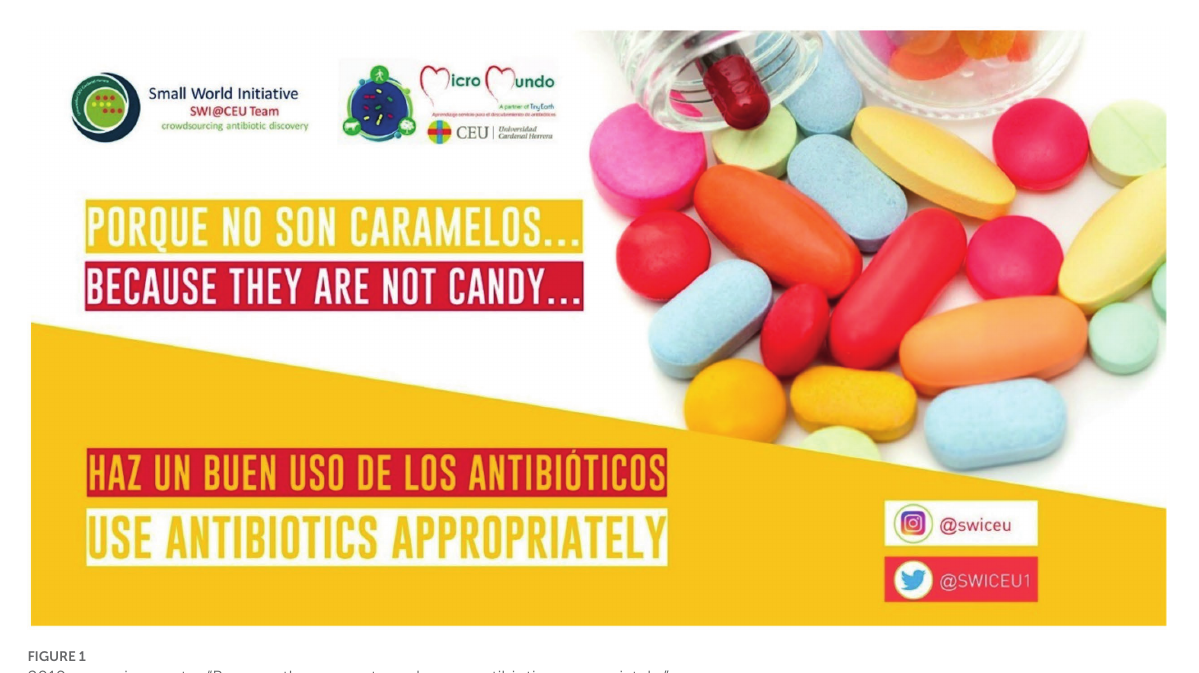
FIGURE 1 2019 campaign poster “Because they are not candy.. use antibiotics appropriately.”